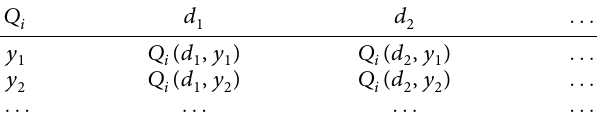
Table 1: Value table of each